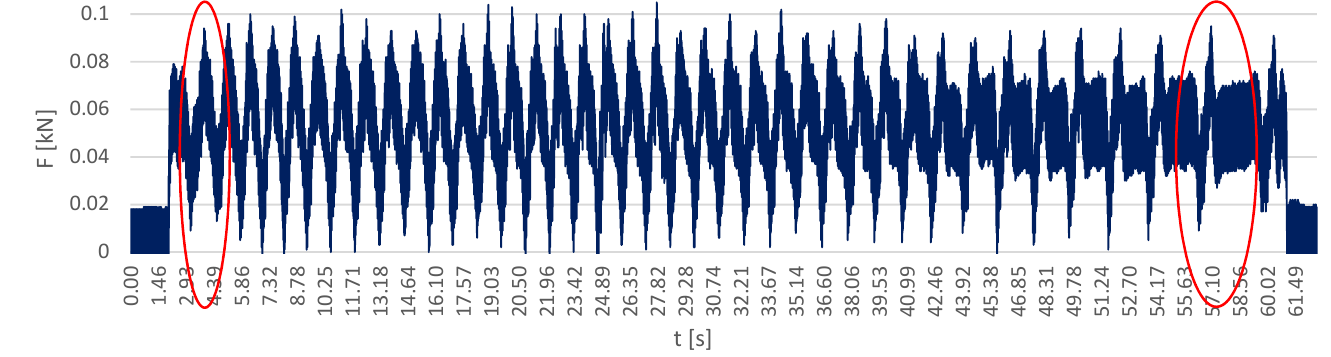
Figure 7. Evolution of forces versus time for execution to the point of refusal—5 kg load.